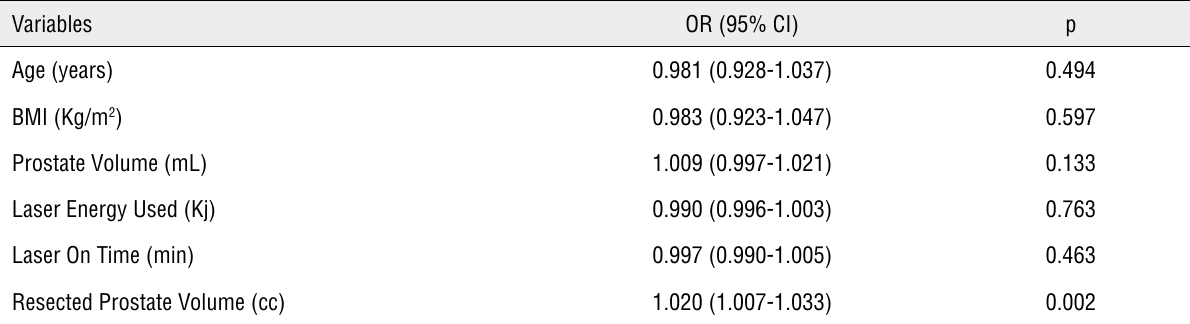
Supplementary Table 1.1 - Results from multivariable logistic regression analysis assessing for risk factors for any SUI in HoLEP patients.